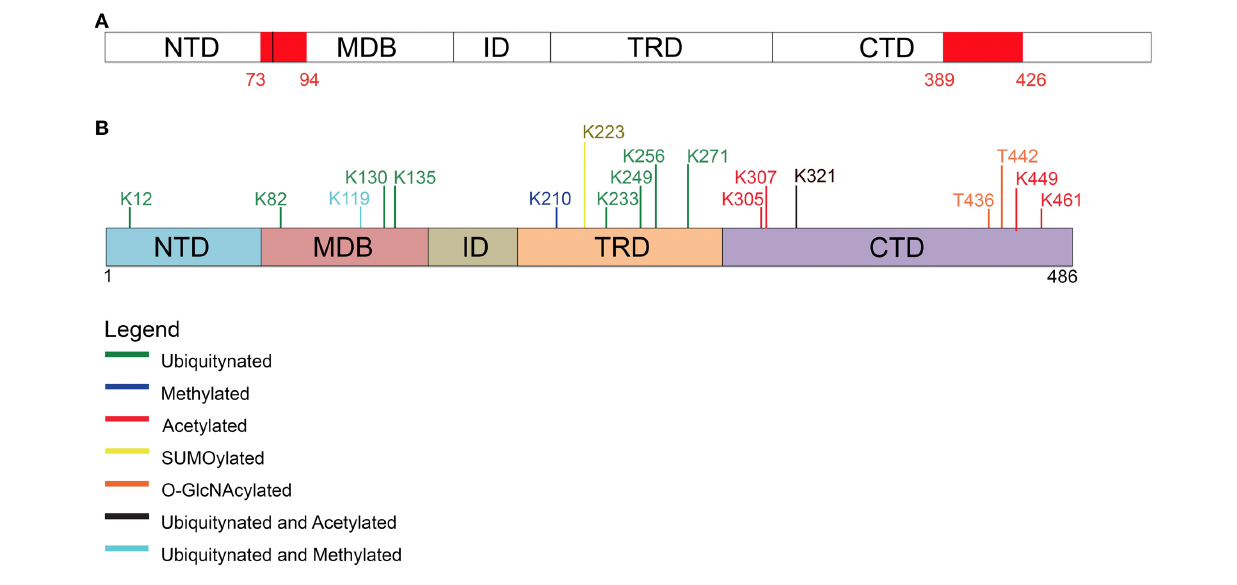
its stability and phosphorylation. (B) Schematic representation of the different types of post-translational modifications (PTM) affecting MeCP2 and the involved amino